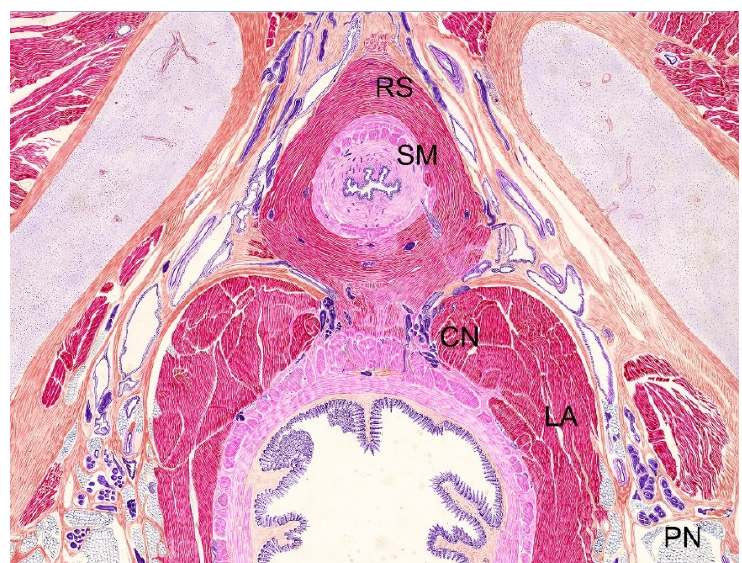
Figure 2. Indian ink on paper drawing from histotopographic 40- μ m transverse section of a male fetus from the Salvador Gil Vernet collection (courtesy of Jose Maria Gil-Vernet Sedó) revealing the omega-shaped circular bundles of rhabdosphincter (RS), inner circular bundles of smooth muscle (SM), levator ani (LA), cavernous nerve (CN) and pudendal nerve (PN).